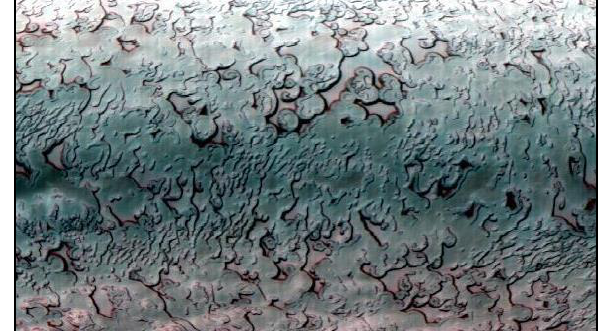
Figure 5: RGB visualisation of CRISM Scene 00005D24